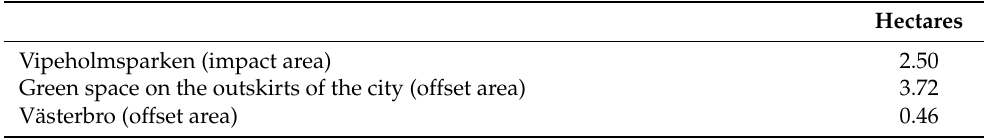
Table 7. How much green space is necessary to achieve the same utility in the offset areas as in the area around the impact area of